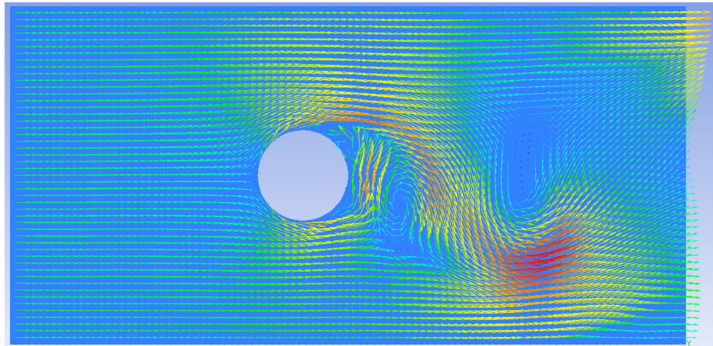
Figure 6. The simulated wind field of wind flow passing the turbine